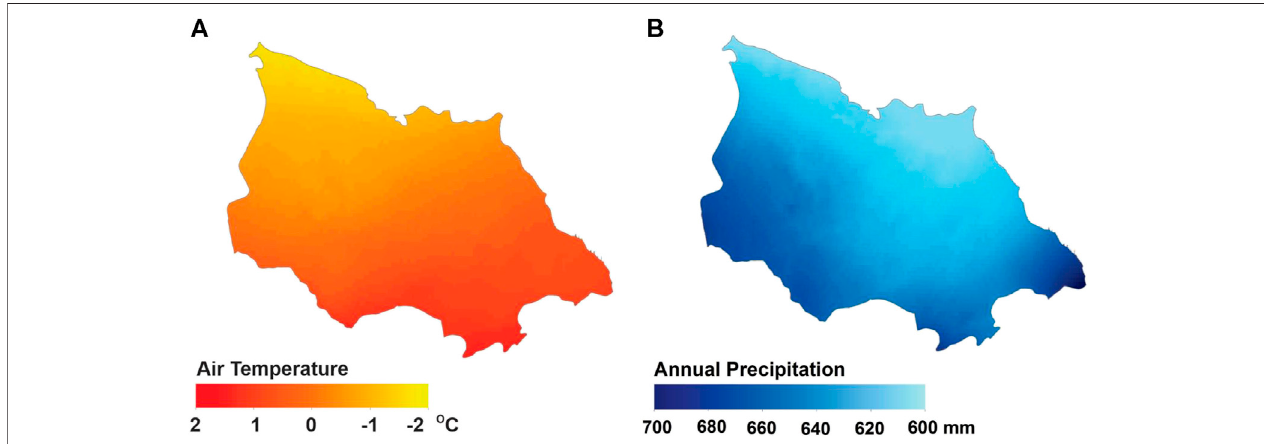
FIGURE 5 | Mean annual air temperature (A) and mean annual precipitation (B) for the 74,300 km 2 study area in the southern Hudson Bay Lowlands, Canada, for the period 1971 – 2000.